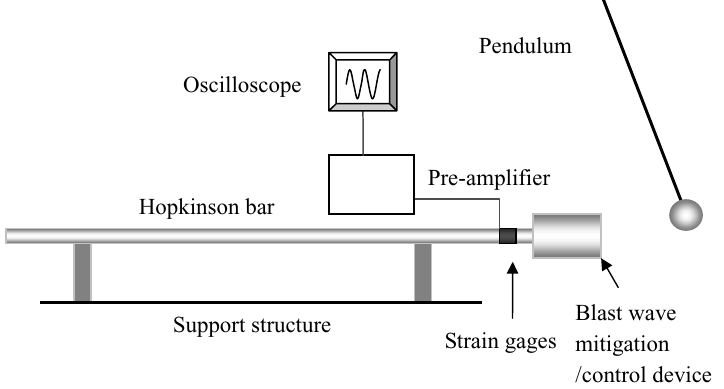
Fig. 5. Schematic of the second experimental setup consisting of a Hopkinson bar and a ball pendulum.